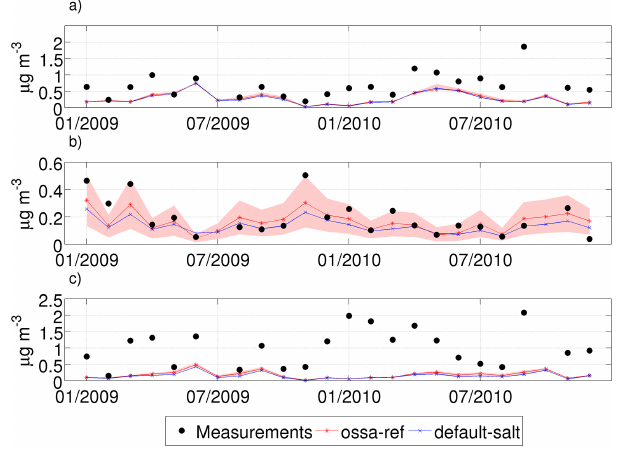
Figure 5. Monthly mean PM 1 mass concentration of (a) sulfate, (b) sea salt and (c) organic matter in the in situ measurements at Mace Head and in the model. The shading around the red line ( ossa-ref ) indicates the spread of the model results from the sensitivity simula- tions. The model PM 1 concentration was calculated by integrating the size distribution up to 1µm in terms of vacuum aerodynamic diameter (see text).